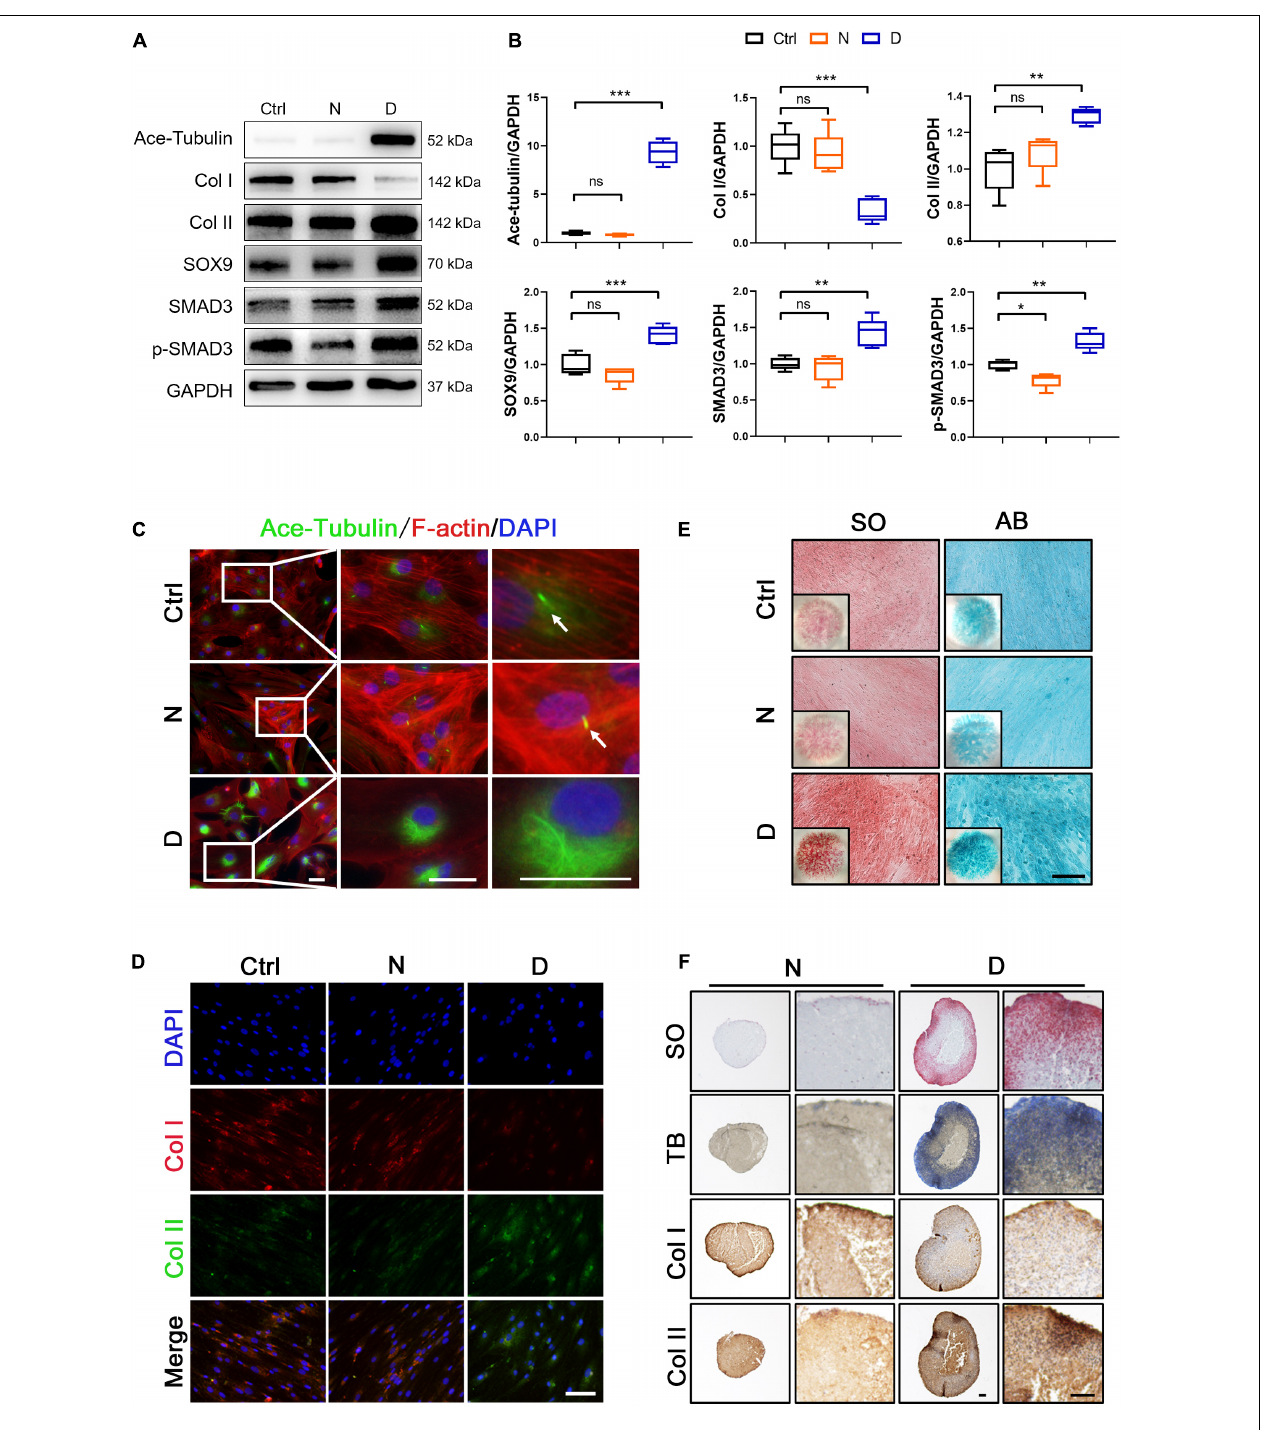
FIGURE 2 | The effect of microtubule (MT) stabilization in the chondrogenesis of SMSCs. (A) Western blot analysis of Ace-Tubulin, Col I, Col II, SOX9, SMAD3, and phosphorylated SMAD3 expression in synovial mesenchymal stem cells (SMSCs) treated with nocodazole (N) and docetaxel (D) in chondrogenic medium (CM) for 1 week. (B) Quantification of the data of (A) . n = 5. (C) Immunofluorescence staining of Ace-Tubulin and F-actin. Scale bar, 50 µ m. The docetaxel treatment increased the expression level of Ace-Tubulin. (D) Co-immunofluorescence staining of Col I and Col II. Scale bar, 100 µ m. (E) Safranin O staining (SO) and Alcian blue (AB) staining of SMSC micro-mass culture grown in chondrogenic medium (CM) treated with nocodazole (N) and docetaxel (D) for 4 weeks. (F) pellet cultures of SMSCs in chondrogenic medium (CM) treated with nocodazole and docetaxel for 4 weeks. SO staining, toluidine blue (TB) staining, and immunohistochemical staining of Col II and Col I were performed to access the chondrogenesis of SMSC pellets. Scale bar, 100 µ m. Data are represented as the mean ± SEM. * p < 0.05, ** p < 0.01, *** p < 0.001.